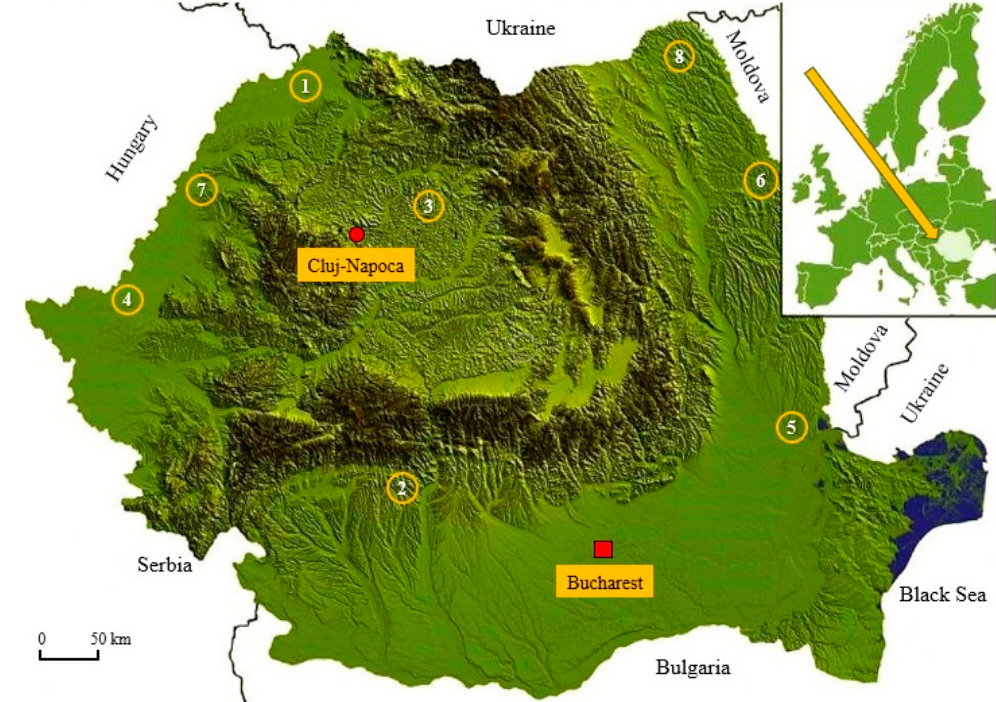
Figure 1. The Romanian provenances of R. pseudoacacia seeds. To characterise the climatic heterogeneity of the different collection sites, mean annual temperature and mean precipitation were considered (Table 1). Seeds were collected in the autumn of 2020. After harvesting, seeds were labeled for each provenance and deposited in paper bags in a refrigerator (at approximately +4 ◦ C) until further